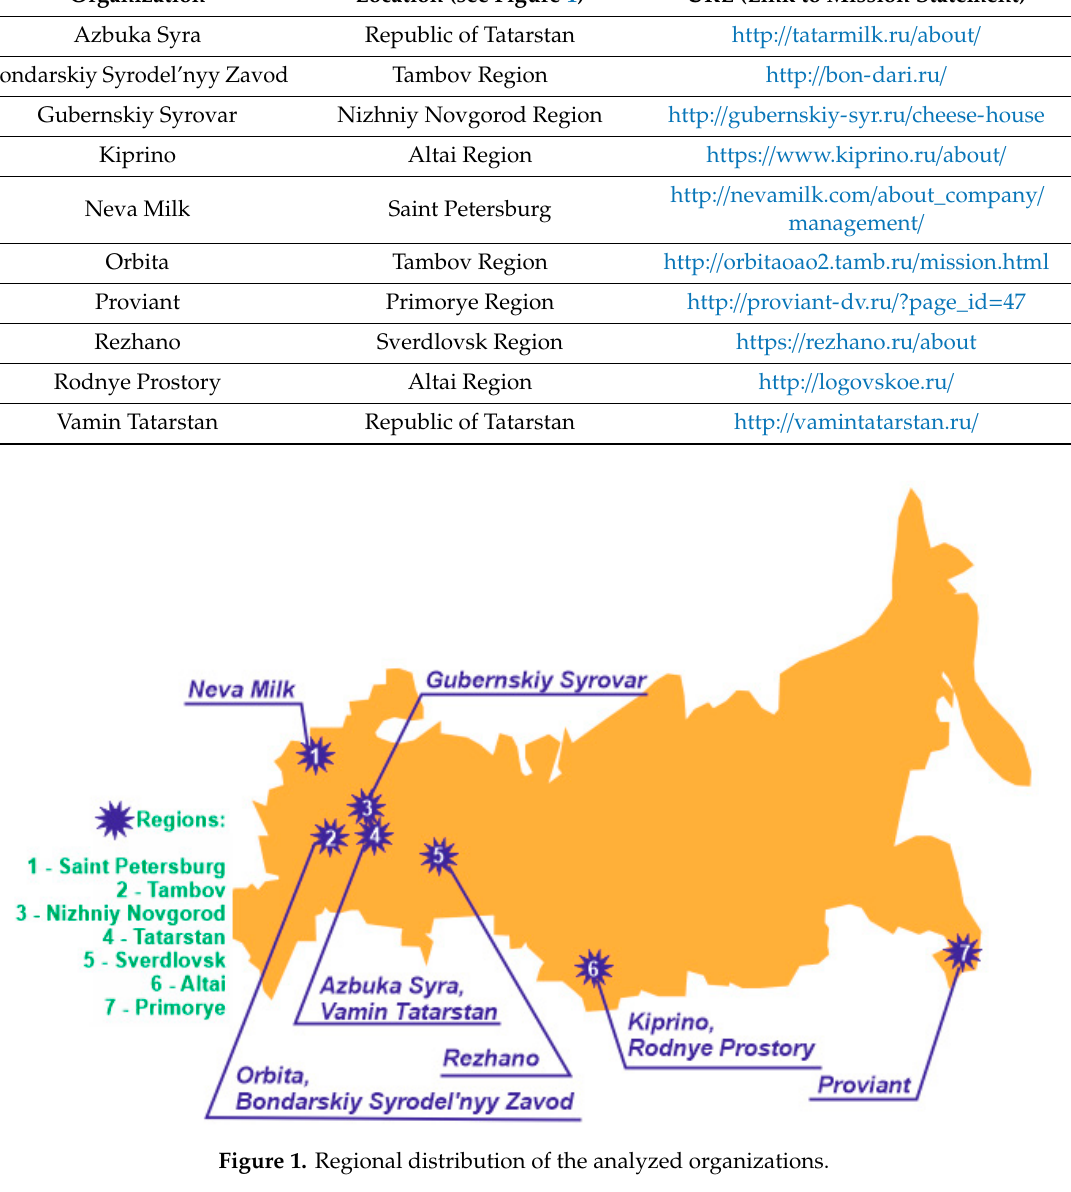
Table 1. Analyzed organizations and sources of the mission statements.